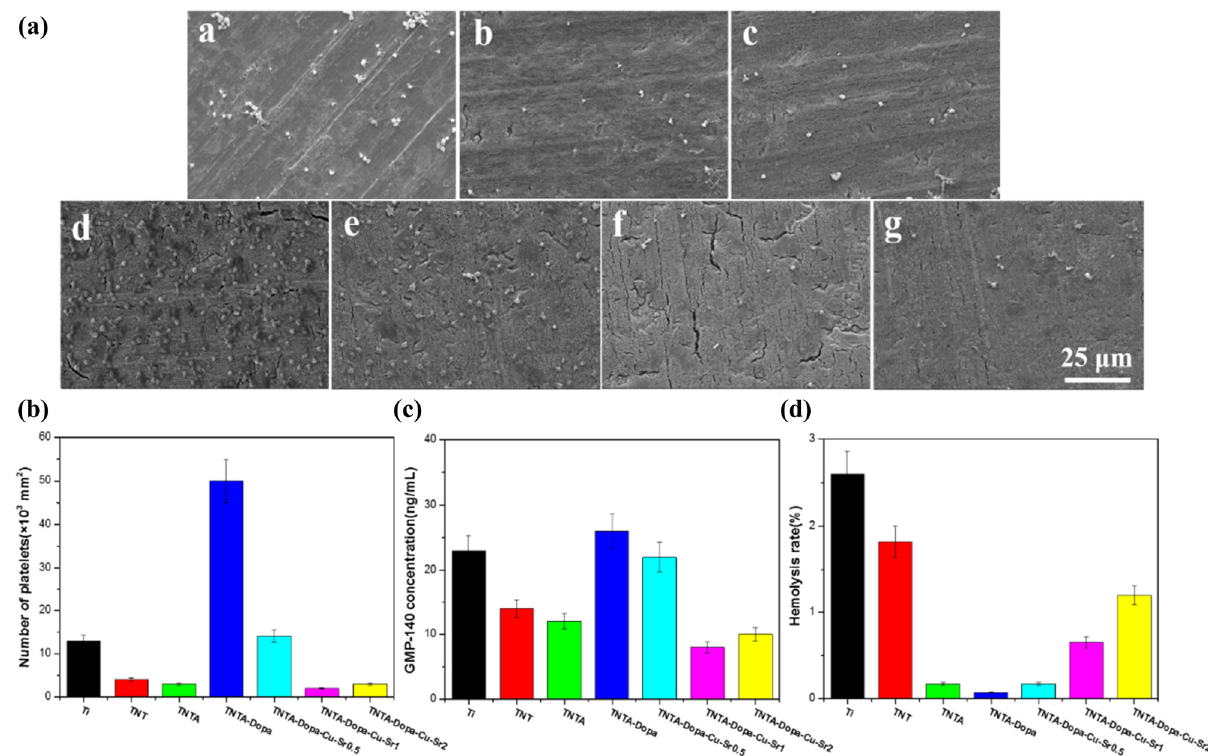
Figure 6: ( a ) SEM images of platelets adhered on the surface of pure Ti ( a ) , TNT ( b ) , TNTA ( c ) , TNTA – Dopa ( d ) , TNTA – Dopa – Cu – Sr0.5 ( e ) , TNTA – Dopa – Cu – Sr1 ( f ) , TNTA – Dopa – Cu – Sr2 ( g )) ; ( b ) the number of the platelets on the di ff erent samples; and ( c ) and ( d ) are the results of GMP140 and the hemolysis rate for the di ff erent samples,